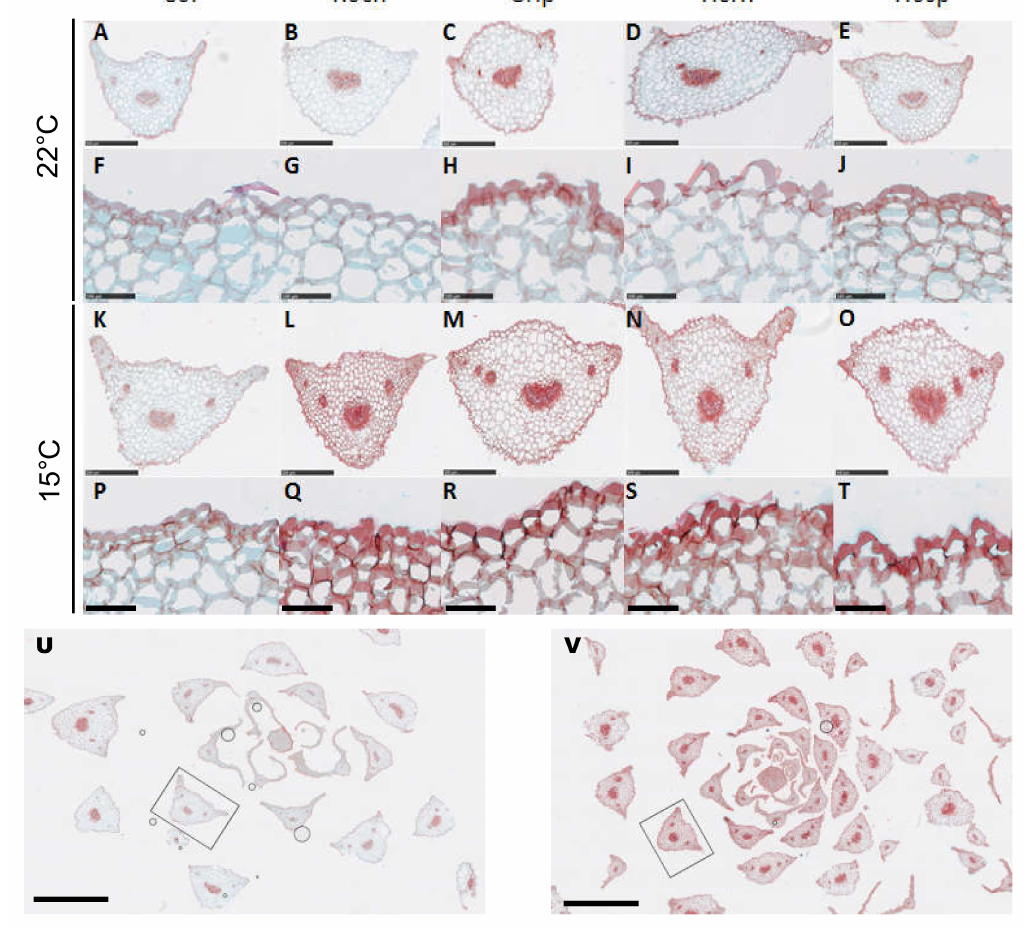
Figure 2. Phenotyping of leaf petioles of Col, Roch, Grip, Hern and Hosp at the bolting stage after 4 or 6 weeks of culture at 22 ◦ C ( A – J ) or 15 ◦ C ( K – T ). Cross-sections were stained with safranin red and astra blue. Representative plant petioles among more than 30 petioles from independent batches are shown. The black frames in ( U , V ) show the petiole cross-section displayed in ( K , L ) at a higher magnification, respectively. Scale bars represent 500 µ m ( A – E , K – O ), 100 µ m ( F – J , P – T ) or 2 mm ( U , V